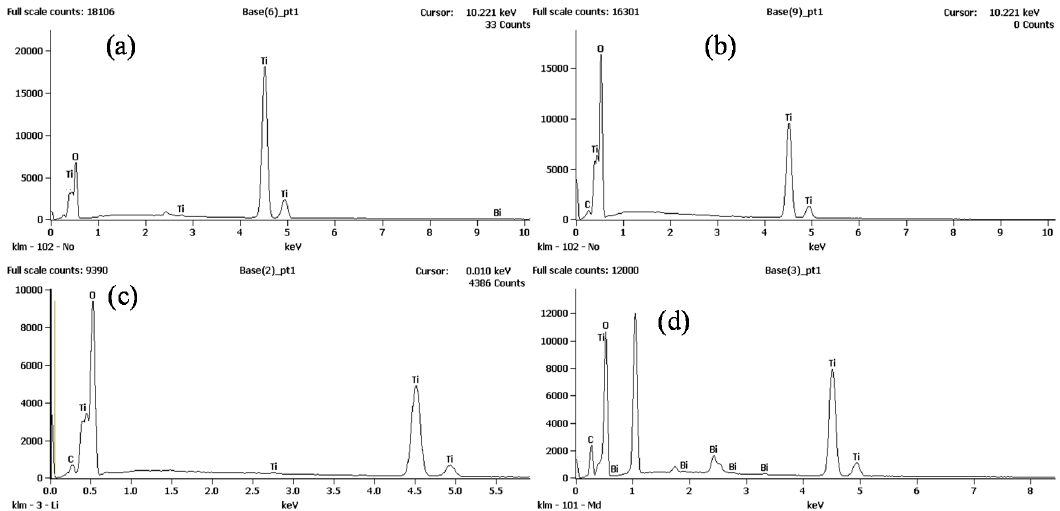
Figure 2. EDX spectrum of ( a ) TNTs, ( b ) GO ‐ TNTs, ( c ) RGO ‐ TNTs, and ( d ) Bi ‐ TNTs composites.